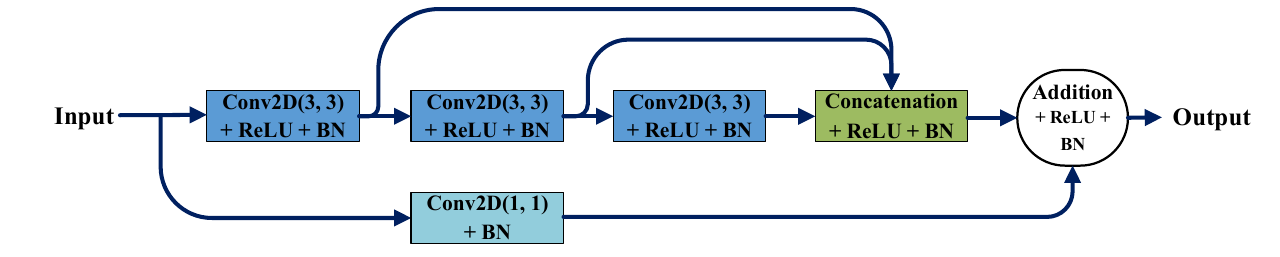
Figure 2. The structure of MultiRes blocks.